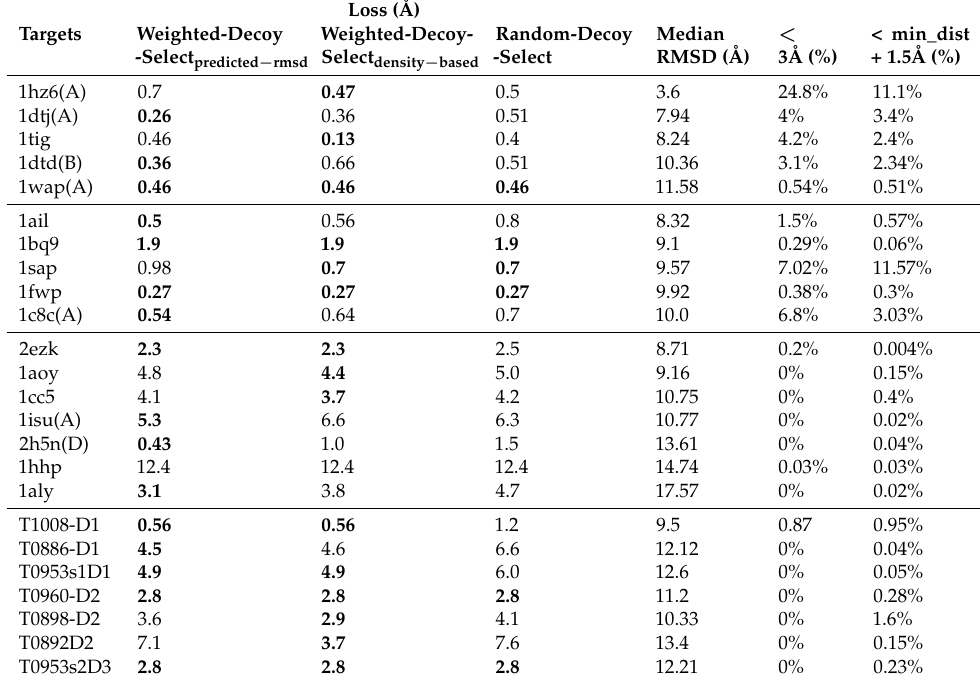
Table 3. Columns 2–4 relate the loss obtained from Weighted-Decoy-Select predicted − rmsd , Weighted- Decoy-Select density − based , and Random-Decoy-Select , respectively. Columns 5–7 show the median RMSD (over all decoys in a dataset) from the known native structure, the percentage of decoys in each dataset with RMSDs less than 3Å from the known native structure, and the percentage of decoys with RMSDs less than 1.5Å from the best decoy (closest to the known native structure). The last seven rows show results for the CASP targets. Lowest loss per target is highlighted in